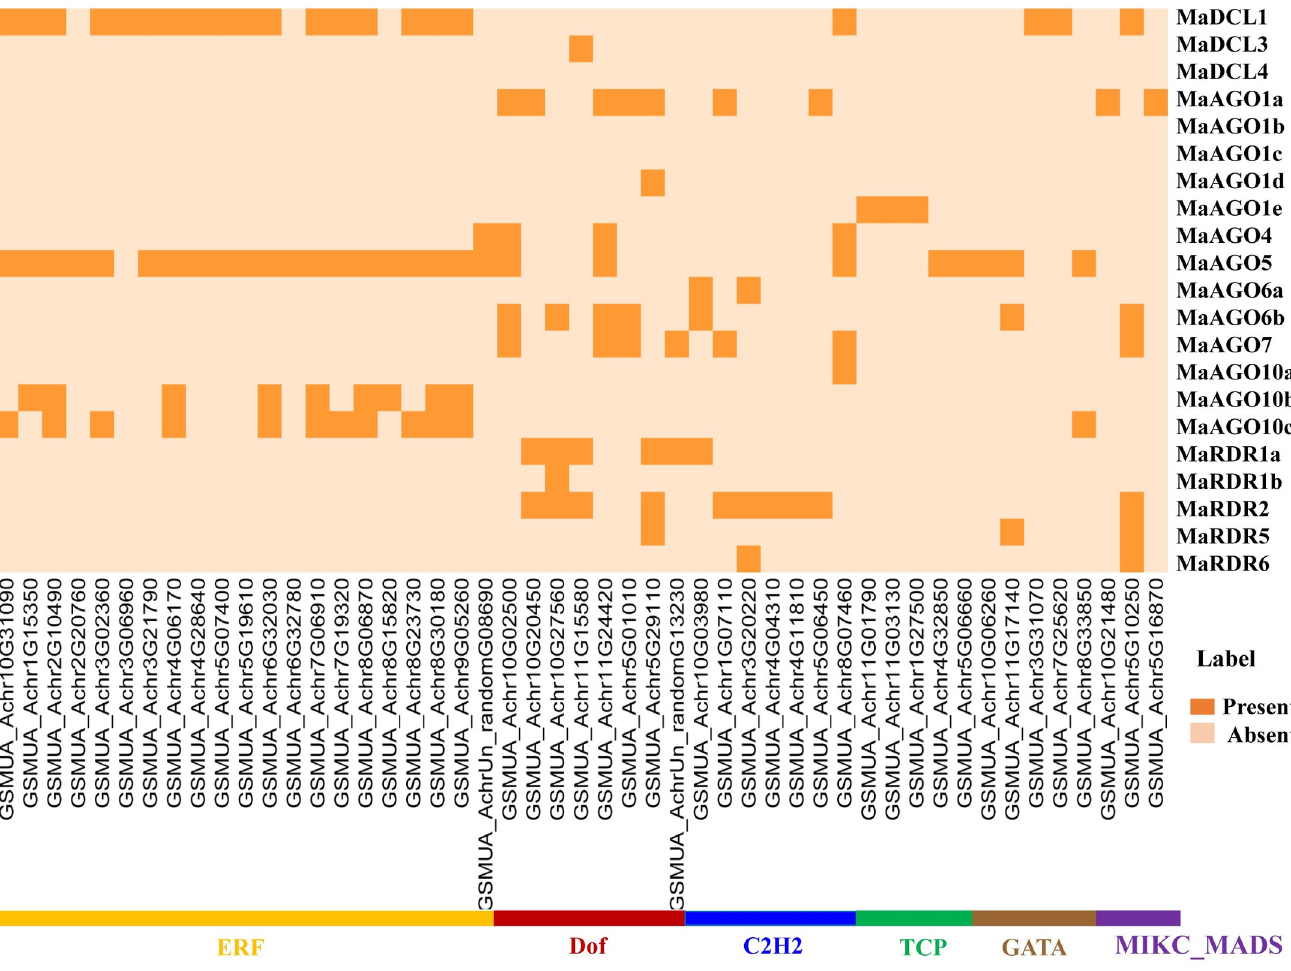
Fig 13. RNAi gene-mediated sub-network for ERF, Dof, C2H2, TCP, GATA and MIKC_MADS TFs families which is expressed as Heatmap.